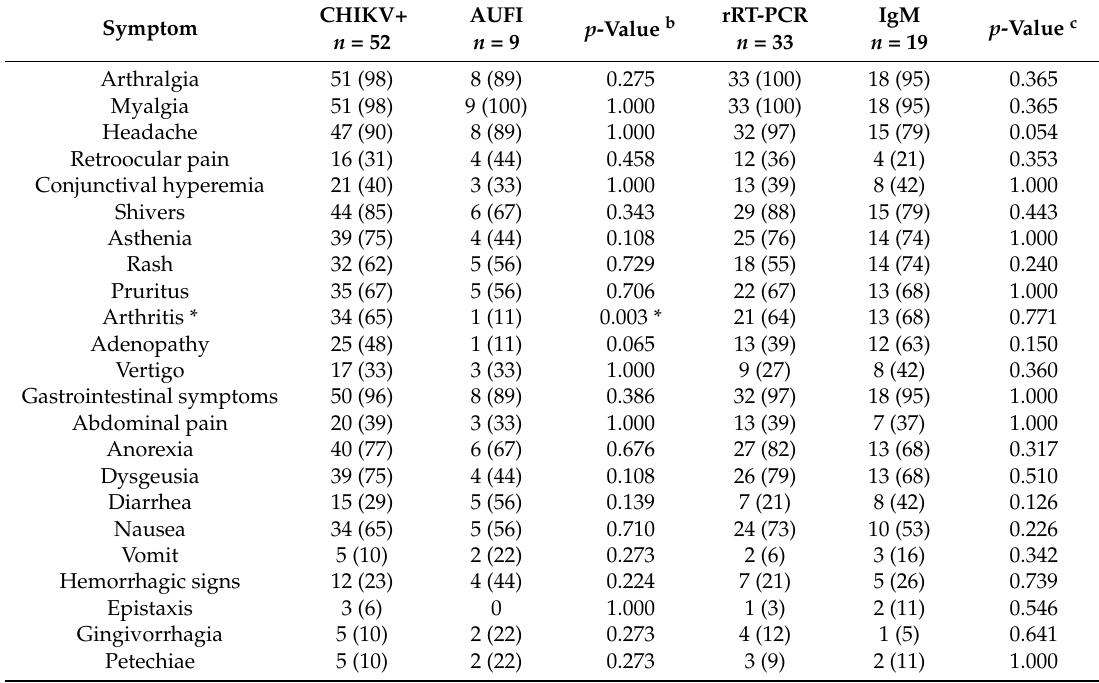
Table 1. Clinical features of the studied patients in Tapachula, Chiapas, June through July 2015 a .